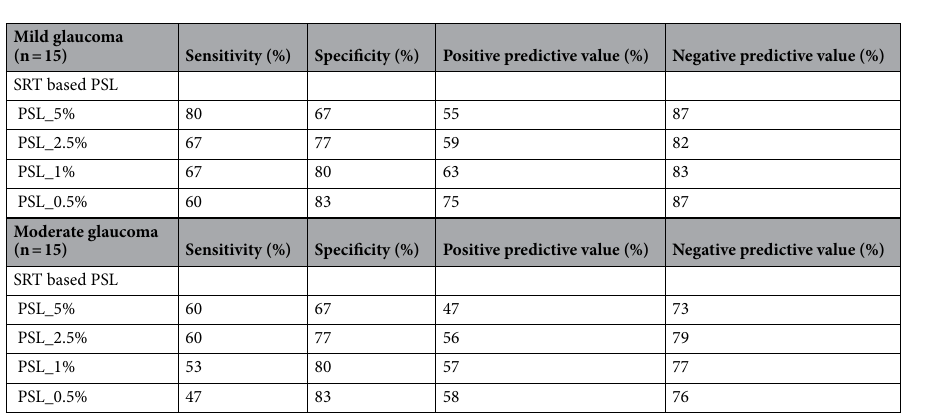
Table 8. Diagnostic ability of PSLs from eye movement perimetry in mild and moderate glaucoma using the HAP classification 17 as reference. *HAP classification: Hodapp Parish and Anderson classification 17 .